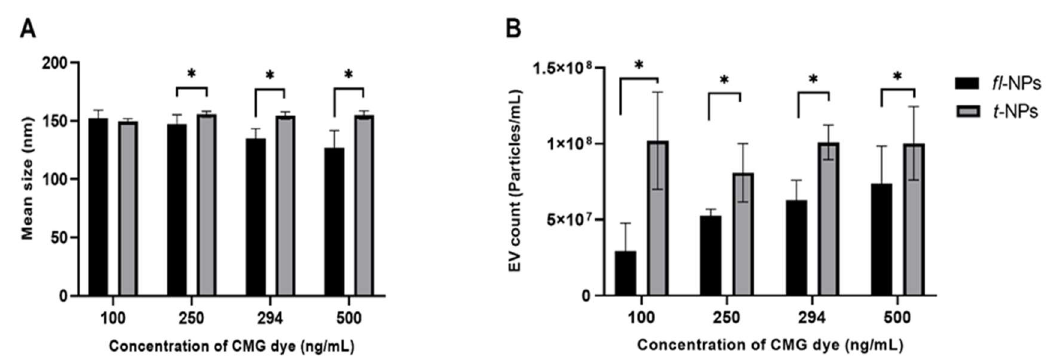
Figure 5. The mean size distribution and concentration for JAr EVs labeled with CellMask™ Green (CMG). All EV types were labeled with different concentrations of CMG (100, 250, 294 and 500 ng/mL respectively). Particle means size ( A ) and concentration ( B ) for respective fl and t -NPs originating from JAr cells measured in fluorescent and scatter modes. The mean particle size and concentration of fl -NPs were significantly different ( p ≤ 0.05) than t -NPs at all concentrations of CMG, except the mean particle size comparison between fl -NPs and t -NPs at the lowest concentration of CMG. Thus, were marked with an asterisk (*) symbol (mean ± SD, n = 9).